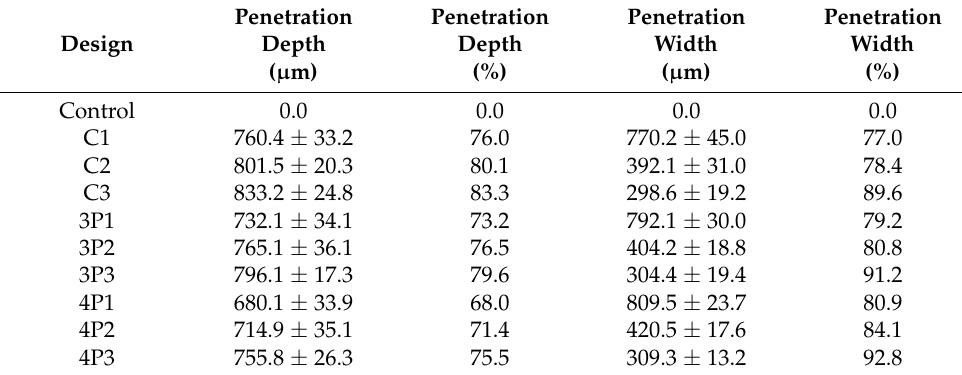
Table 2. Penetration characteristics (depth and width) in mouse skin using finger pressure ( n = 3). C: cone, 3P: 3-sided pyramid, 4P: 4-sided pyramid.